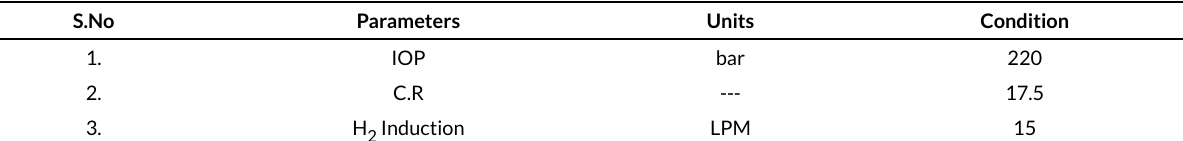
TABLE 8. OPTIMAL PARAMETER CONDITION